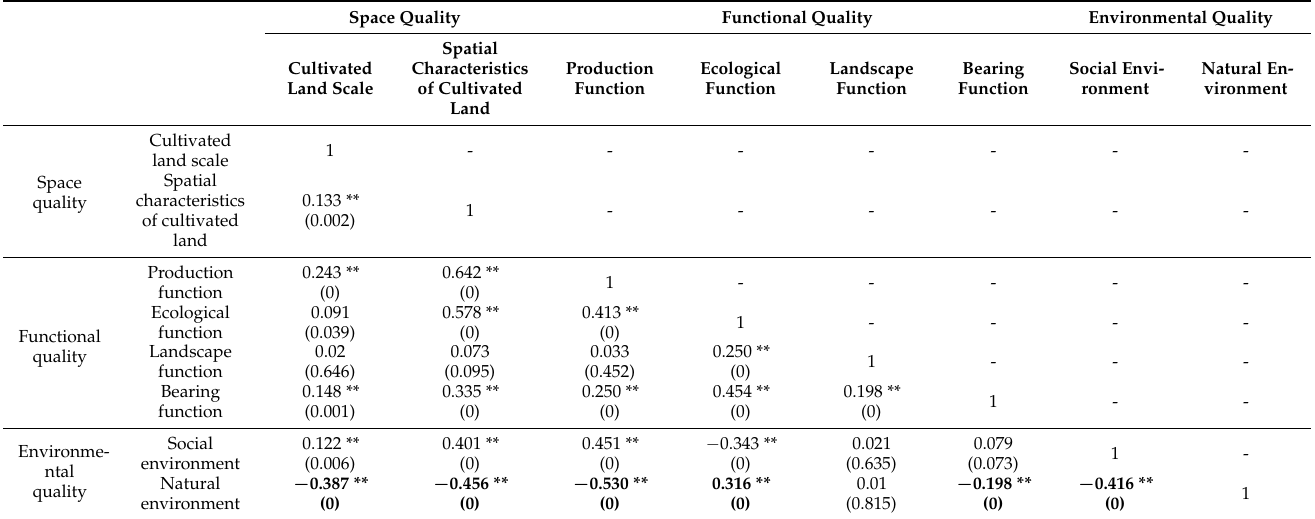
Table 3. Spearman rank correlation statistical table of cultivated land quality indicators. Space